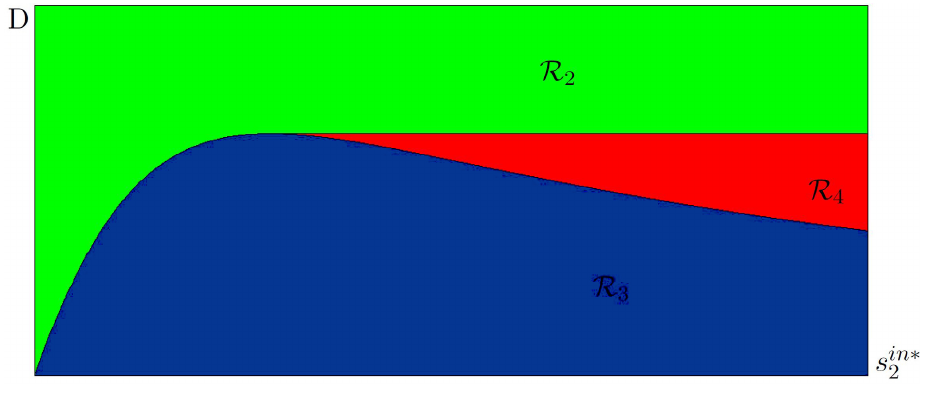
Figure 3. Operating diagram of System